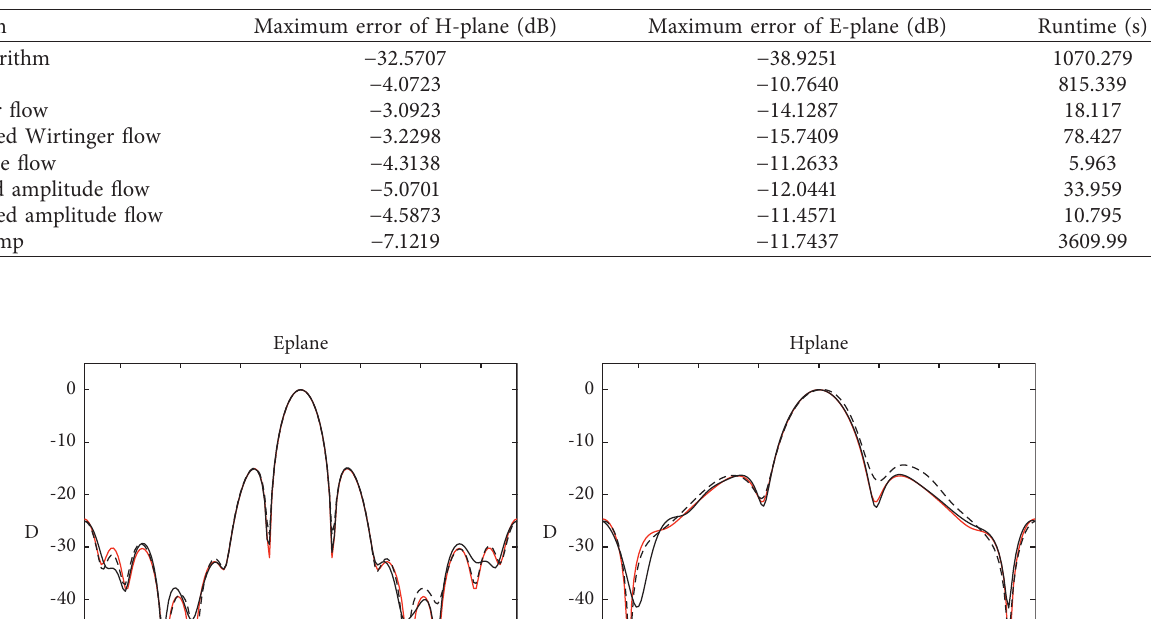
Figure 16: The obtained radiation pattern of dipole array by adopting the proposed algorithm. (a) E-plane. (b) H-plane. Table 4: The maximum error of extrapolated far field and runtime of the recovery algorithm.